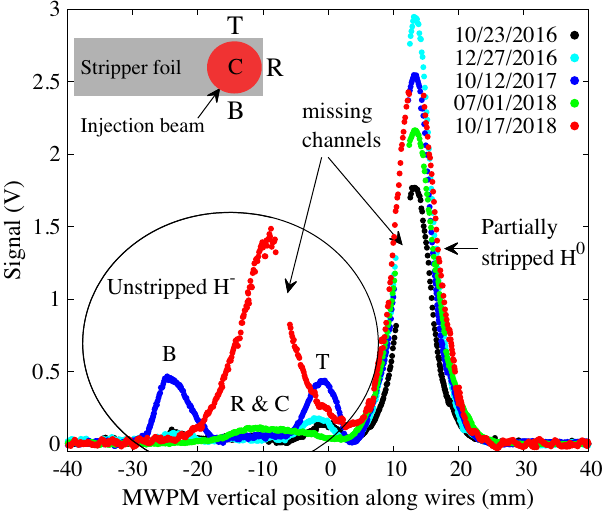
FIG. 14. The vertical profiles of the partially stripped H 0 and unstripped H − beam measured by the MWPM. It can be seen that the H 0 yield increased due to foil thinning, while the missing H − were also significantly increased due to a pinhole outbreak in the foil and its curling